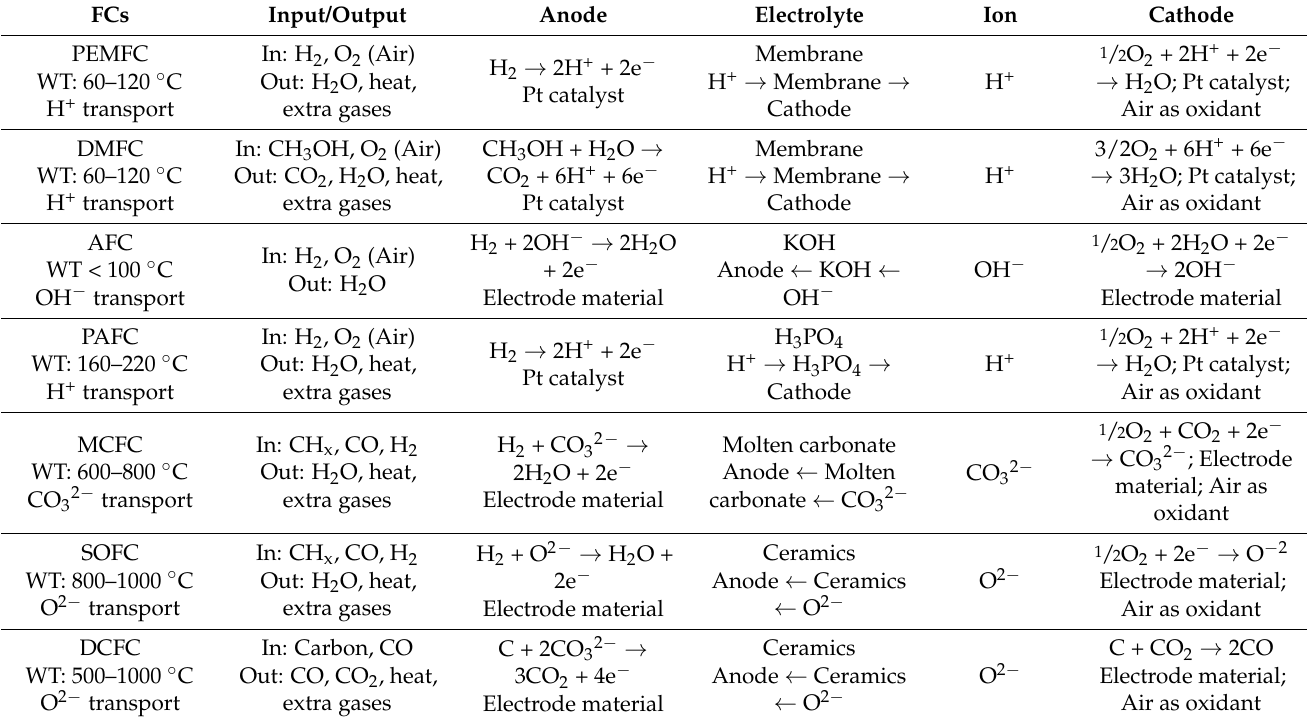
Table 1. FCs, working temperature, and their catalytic mechanisms at two electrodes, both anode and cathode. In addition to the use of Pt catalyst, FCs of high costs must be decreased in the optimization of whole systems and components. Pt-based catalysts or alternative catalysts can be used in both the anode and the cathode of PEMFC, DMFC, and